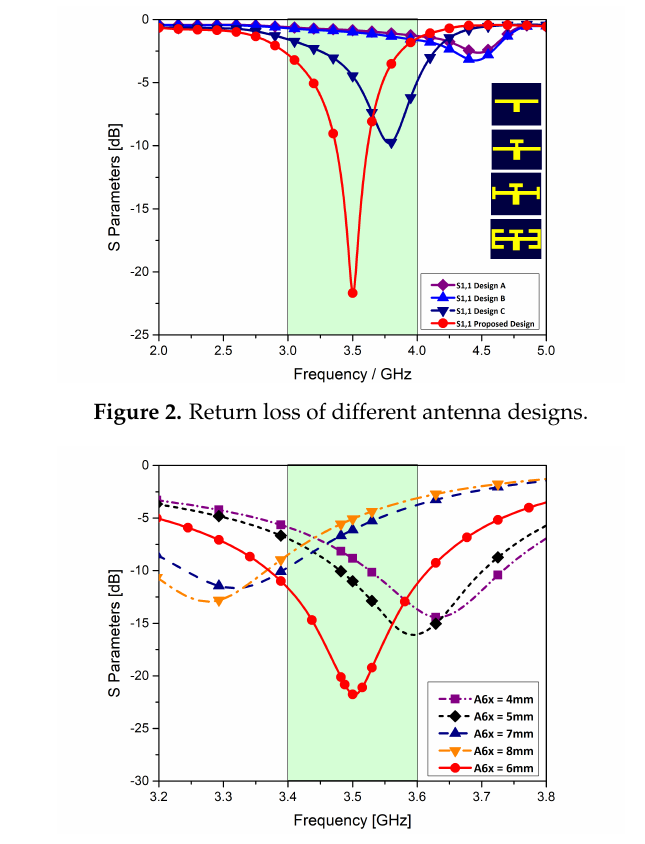
Figure 3. Effects of A6x on the reflection coefficient of a single element.